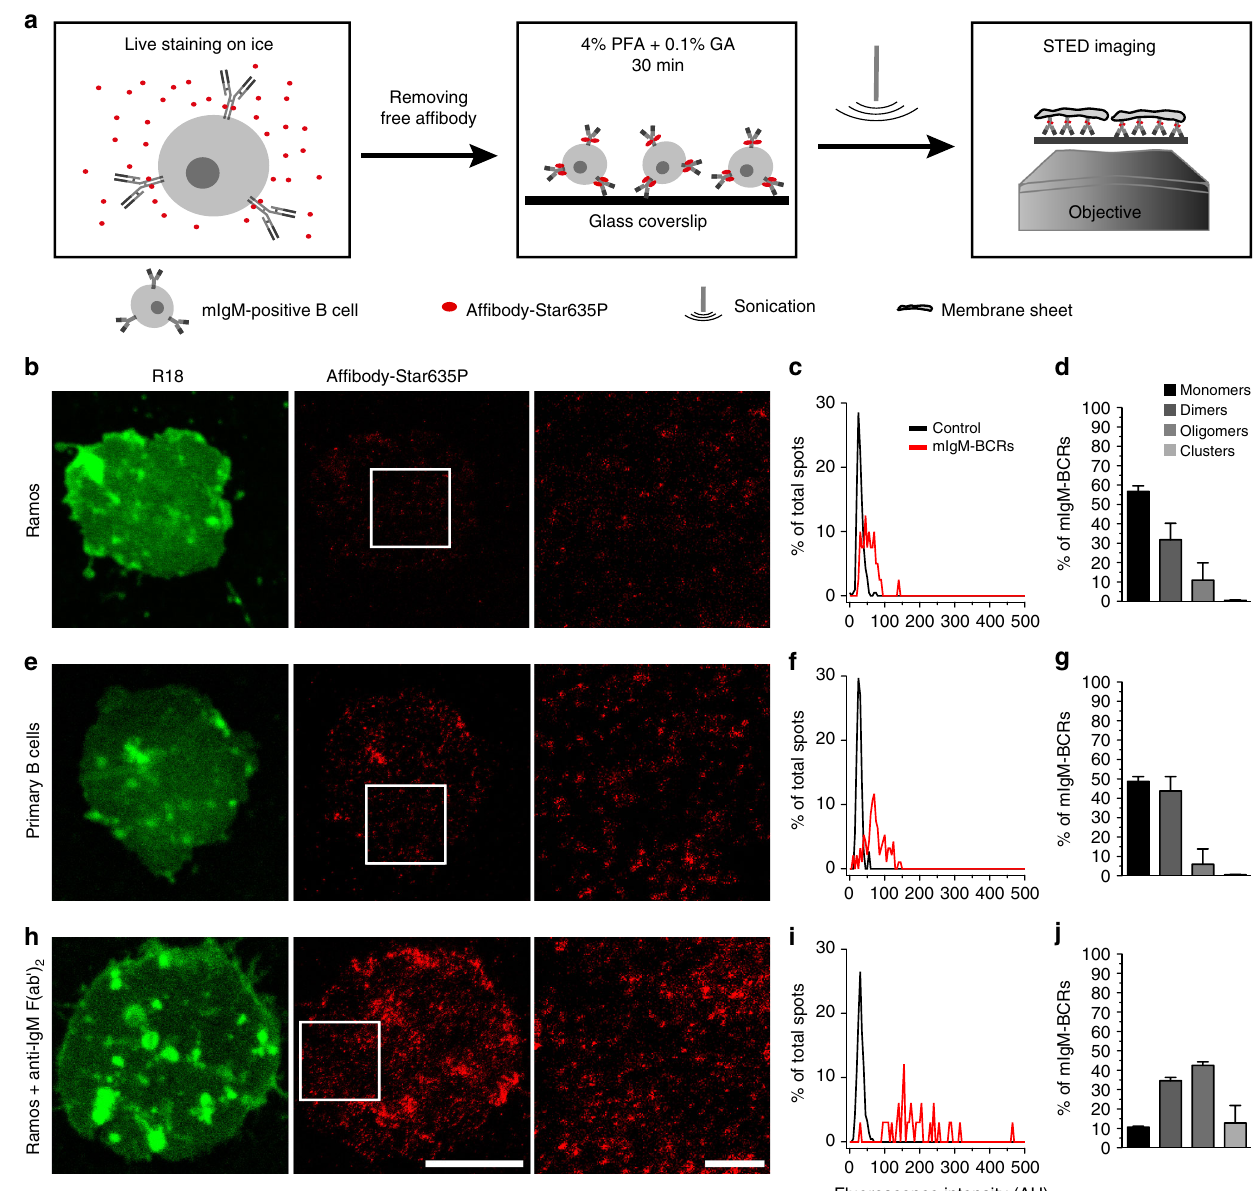
Fig. 1 Arrangement of mIgM-containing BCRs in the plasma membrane of human B cells. a Schematic depiction of the staining procedure and the generation of plasma membrane sheets. b , e , h Images of membrane sheets of unstimulated Ramos B cells ( b ), unstimulated primary B cells ( e ), and Ramos cells stimulated with anti-IgM F(ab ’ ) 2 fragments for 30 min on ice ( h ). Membrane sheets were stained with the membrane marker R18 (confocal images pseudo-colored in green) and anti-human IgM af fi body-Star635P (STED images displayed in red). White squares on central images indicate the zoomed regions that are displayed in the images to their right. Scale bars represent 5 µ m and 1 µ m for the low and high zoom images respectively. c , f , i Example histograms showing the fl uorescence intensity distributions of single Star635P-conjugated af fi bodies on coverslips (black curves, control) and mIgM-spots present in membrane sheets (red curves, mIgM-BCRs). d , g , j Percentages of different mIgM-BCR arrangements in plasma membrane sheets were calculated after pooling the spot intensities of dozens of membrane sheets together and then fi tting the intensity distribution to a sum of Gaussian curves (Supplementary Fig. 2). Data were obtained from four and three independent experiments including a total of 30 membranes from unstimulated and 15 membranes from F(ab ’ ) 2 -stimulated Ramos B cells, respectively. The experiments with primary human B cells were performed three independent times from two different donors and 30 membrane sheets were analyzed in total. Error bars represent the 68% con fi dence interval, corresponding to 1 standard deviation. Histogram ’ s source data are provided as a Source Data fi